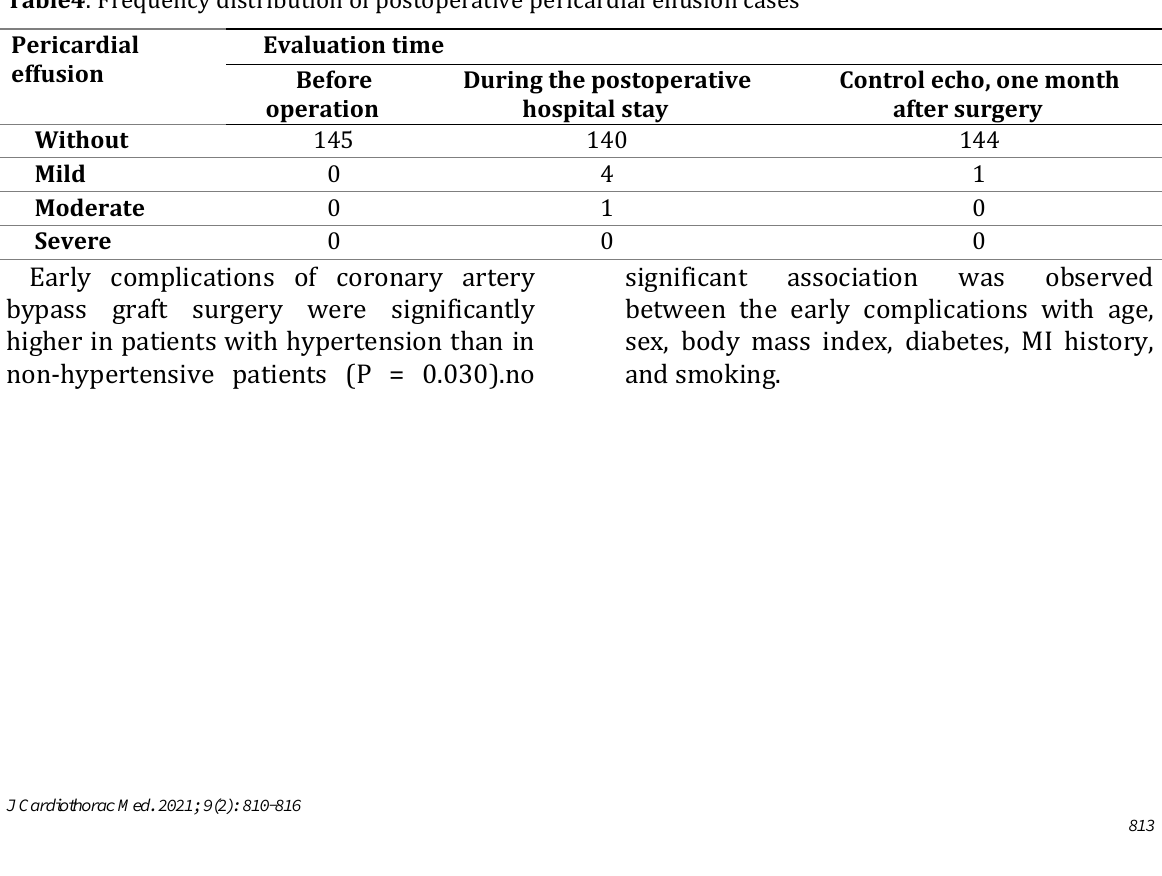
Table4 : Frequency distribution of postoperative pericardial effusion